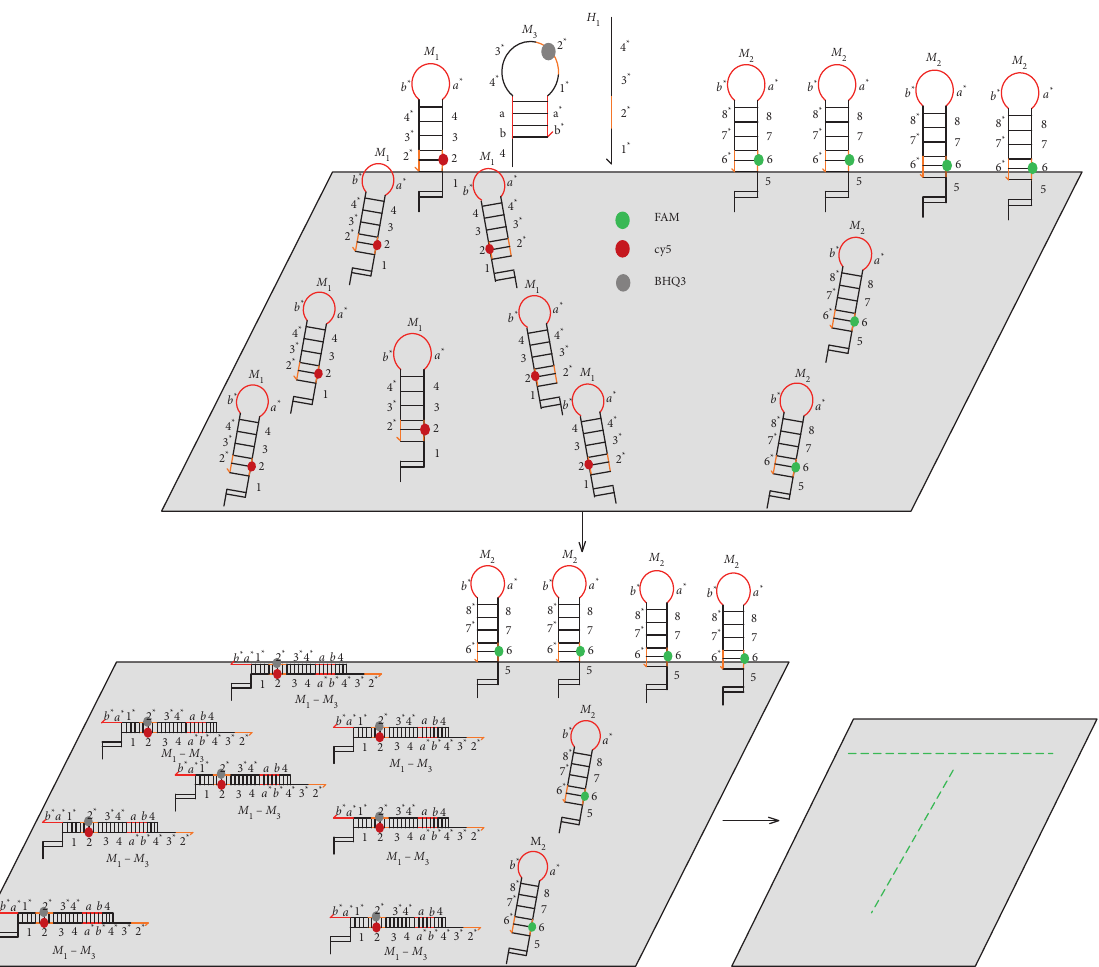
Figure 12: The case of NAND gate input (1,